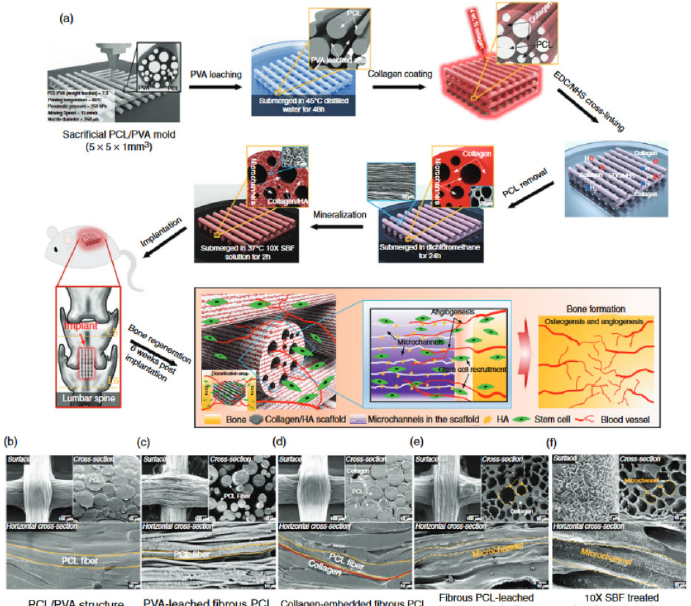
Figure 9. 4D-printed scaffolds with its microscopic image. ( a ) Representation of development of mineralized, microchanneled collagen scaffold and in vivo assessment of osteogenesis and angiogenesis. SEM morphology of ( b ) PCL/PVA, ( c ) PVA-leached fibrous PCL, ( d ) collagen-embedded fibrous PCL, ( e ) collagen microchannels after leaching fibrous PCL, and ( f ) SBF-treated microchanneled collagen. Reprinted with permission from Ref. [160], Copyright 2020, Elsevier Ltd.